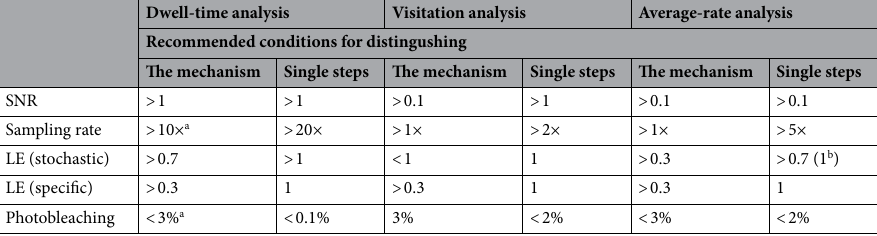
Table 1. Robustness of the analysis methods. a Compared to the fastest rate. b 1 % to obtain the correct conversion